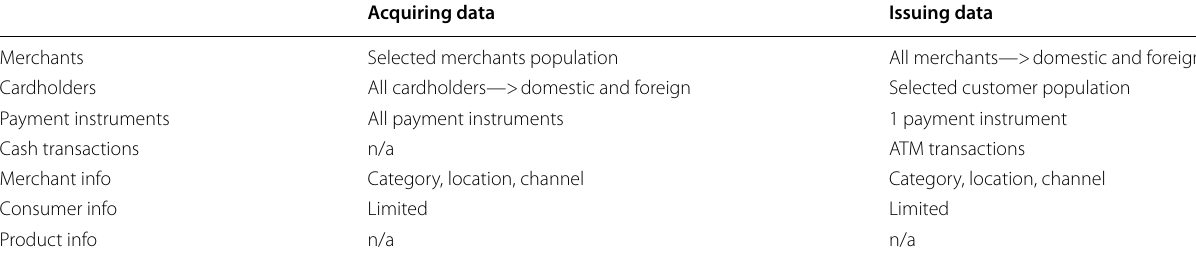
The table displays the different attributes available in the acquiring and issuing data. See Tables 2, 3 and 4 for more details on the data we